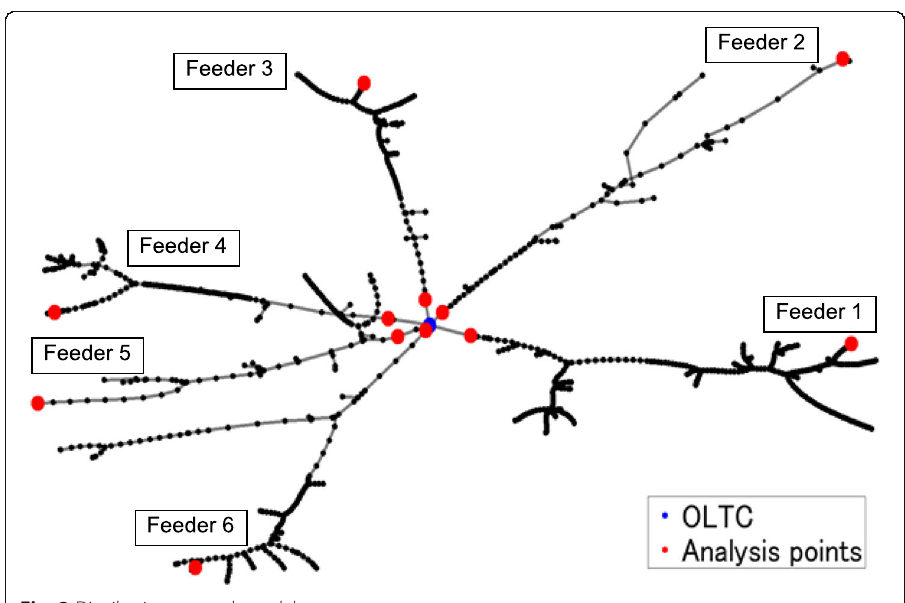
Fig. 3 Distribution network